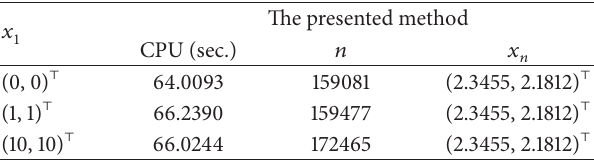
Table 4: Numerical results for Example 13 with 𝑢 = (3, 3) ⊤ .